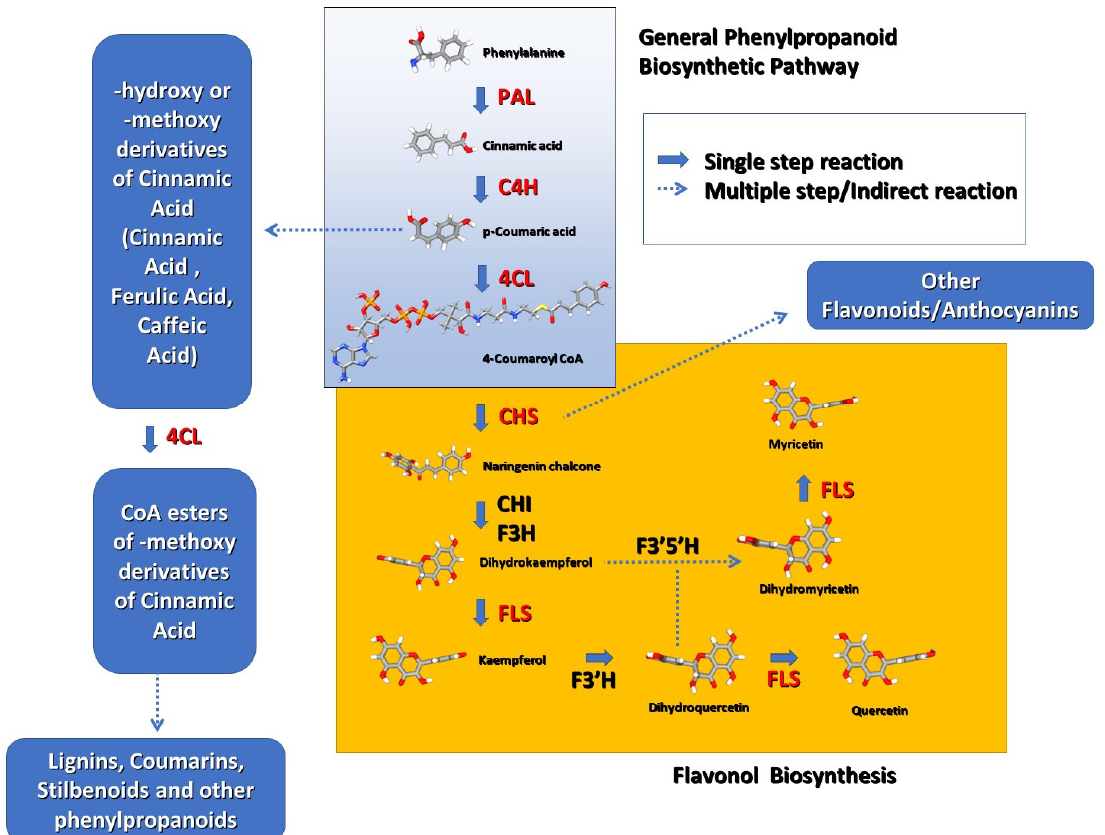
Figure 1. General phenylpropanoid biosynthetic pathway (consisting of phenylalanine-ammonia lyase (PAL), cinnamic acid 4-hydroxylase (C4H), and 4-coumarate-CoA ligase (4CL) enzymes) preceding flavonoid biosynthesis (mediated via chalcone synthase (CHS) and flavonol synthase (FLS)